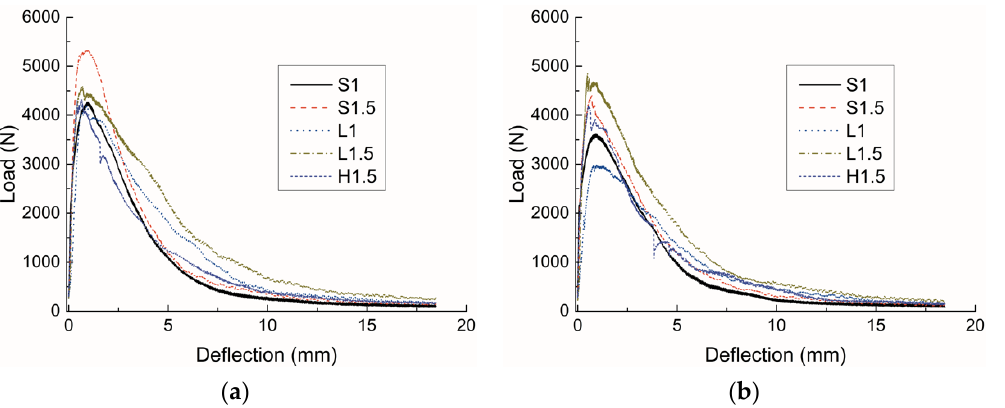
Figure 5. Representative load – deflection curves of all UHPCs with two different casting positions: